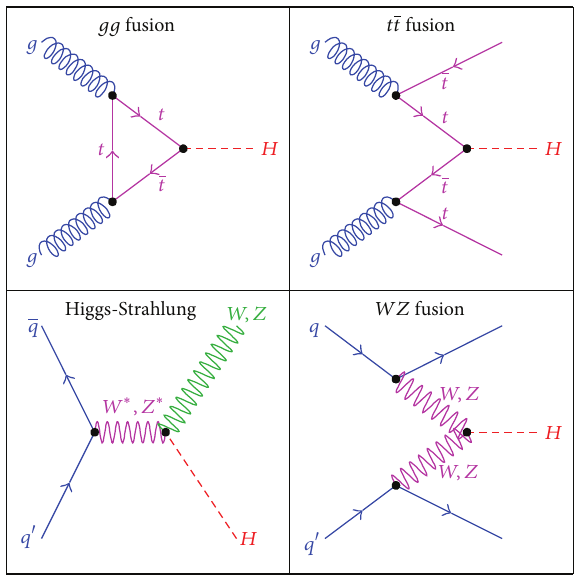
Figure 1: Feynman diagrams of the main processes of Higgs boson production in 𝑝𝑝 collisions (taken from [52]).